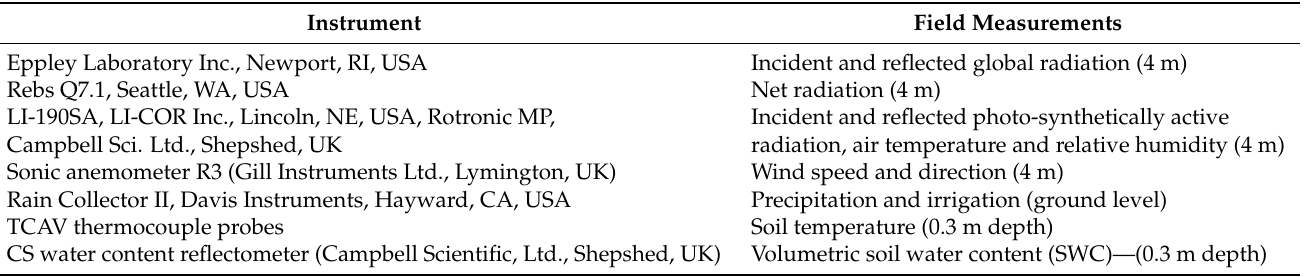
Table 1. Specific characteristics of the instruments installed at the Borgo Cioffi farm in Italy.